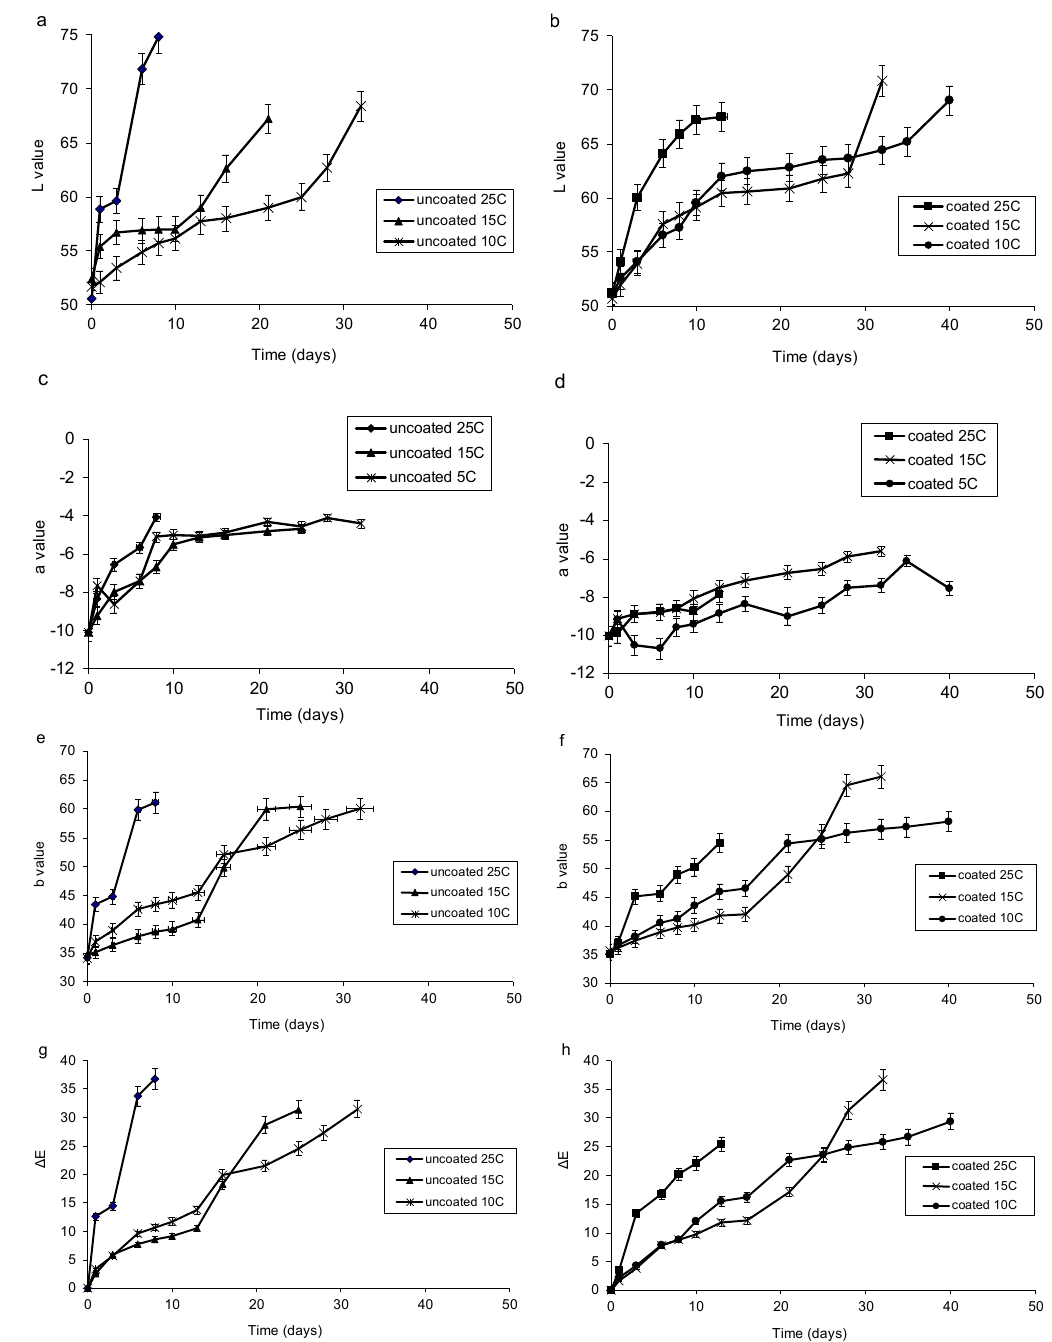
Figure 5. L value ( a , b ), a value ( c , d ), b value ( e , f ), and ∆ E value ( g , h ) of uncoated (control) and coated limes during storage at 10–25 °C.